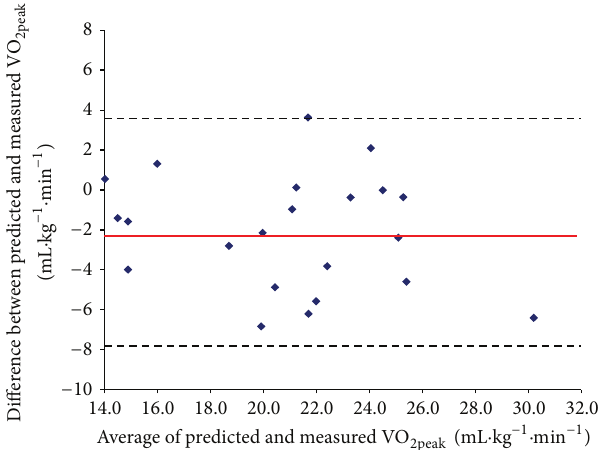
̇ Figure 2: Bland-Altman plot of VO 2 measured during the cycle peak ̇ test and VO 2 max predicted by the Siconolfi step test (visit 2). The mean bias is represented by the solid line and the 95% limits of agreement are represented by the dashed